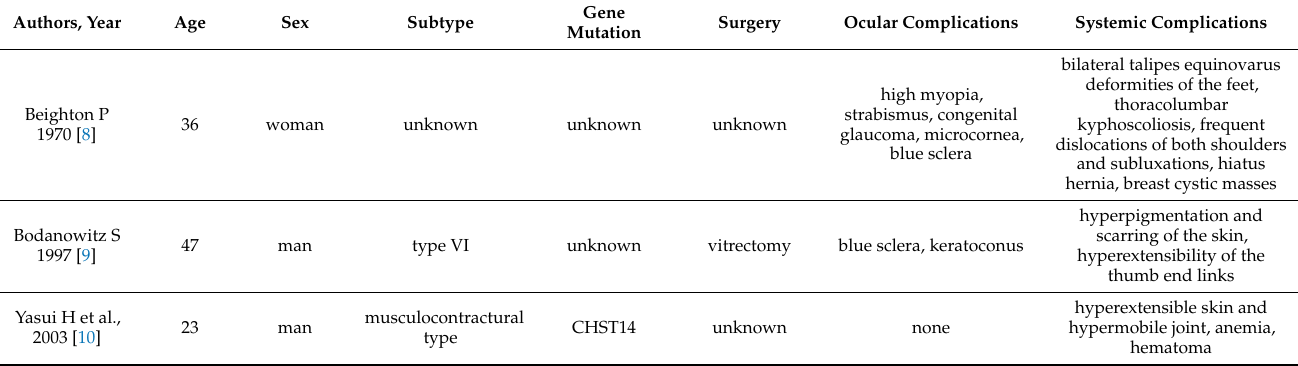
Table 1. Ocular and systemic complications in Ehlers–Danlos syndrome with retinal